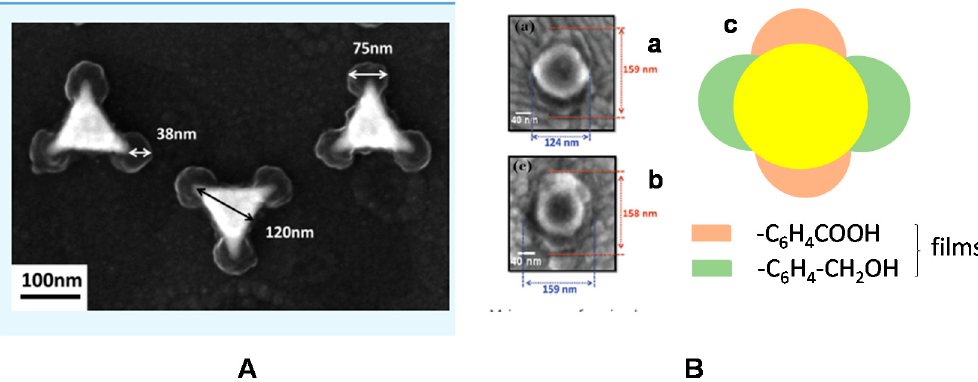
Figure 2. SEM image of ( A ) Au nanotriangles after irradiation with visible light in the presence of 4-[1-(2-bisthienyl)]benzenediazonium, ( B ) nanodiscs modified with visible light (Ba) with carboxyphenyl films grafted along the Y -direction, (Bb) additional hydroxyethyl phenyl films along the X -axis, ( B c) Schematic presentation of the modified nanodisk. From References [23–25], with permission of the American Chemical Society (ACS) and the Royal Chemical Society, respectively.